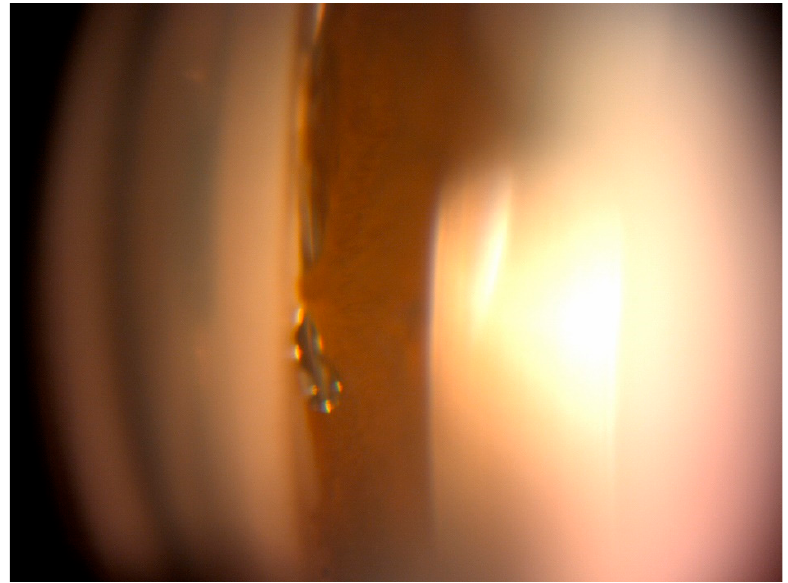
Figure 1. Gonioscopic view of Hydrus microstent showing peripheral anterior synechiae.